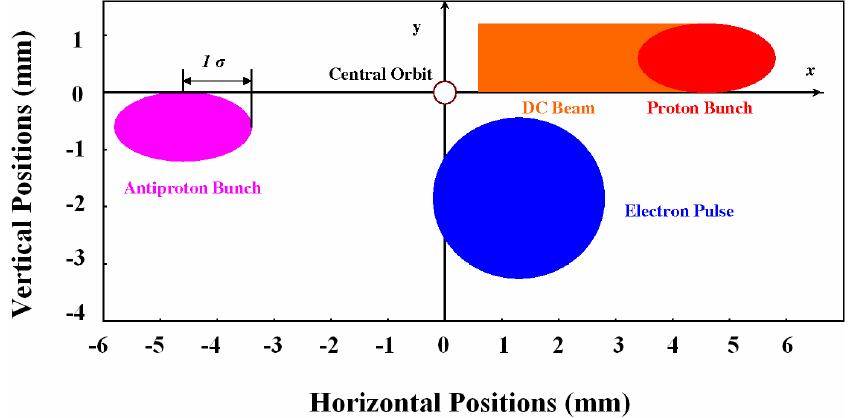
FIG. 11. (Color) The relative positions of the proton, antiproton, and electron beam during uncaptured beam